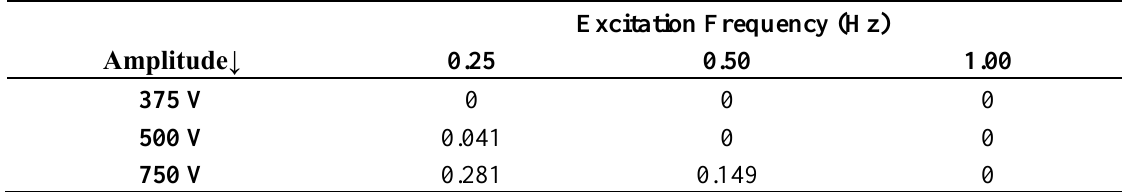
Table 12. Variation of the backlash threshold parameter a 1 .